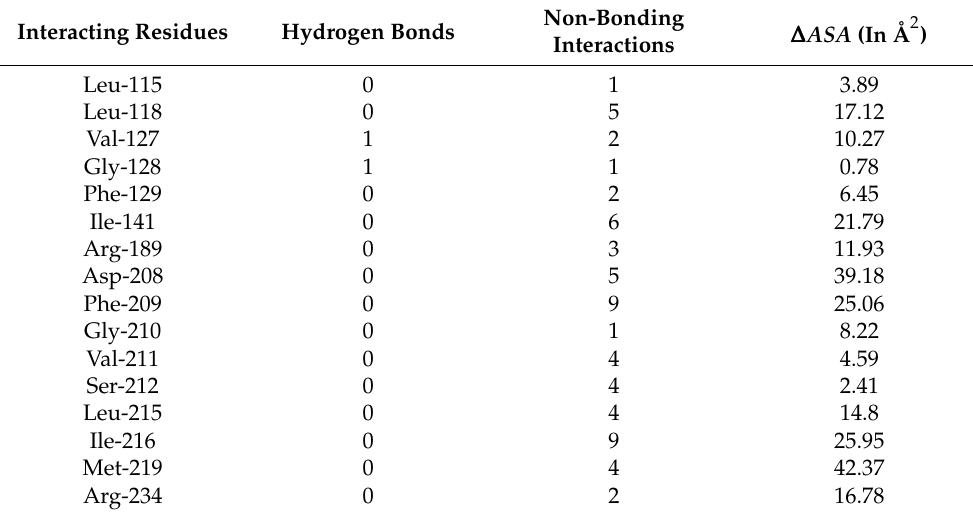
Table 2. The MEK1 residues interacting with selected flavonoid (CID: 129696793) are listed with the number of non-bonding interactions and ∆ ASA .